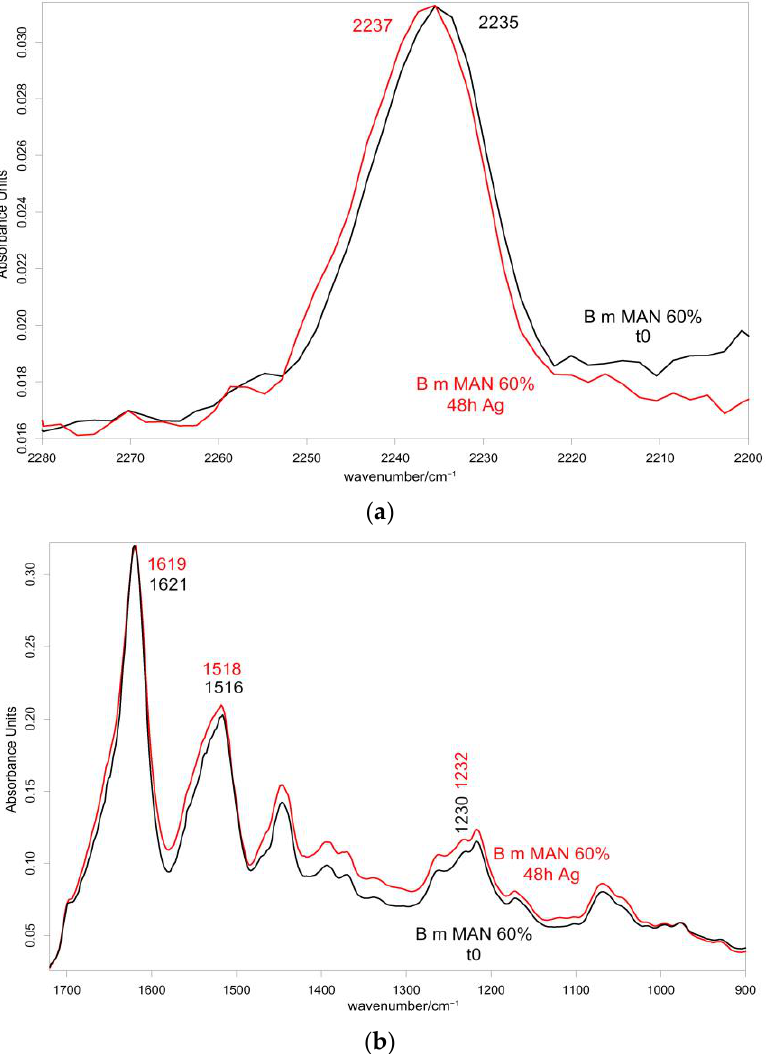
Figure 10. IR spectra recorded in the parallel orientation on the 60% MAN-grafted fibers before and after ageing for 48 h in the Ag + solution in the 2280 – 2200 cm −1 ( a ) and 1720 – 900 cm −1 ( b ) spectral ranges.